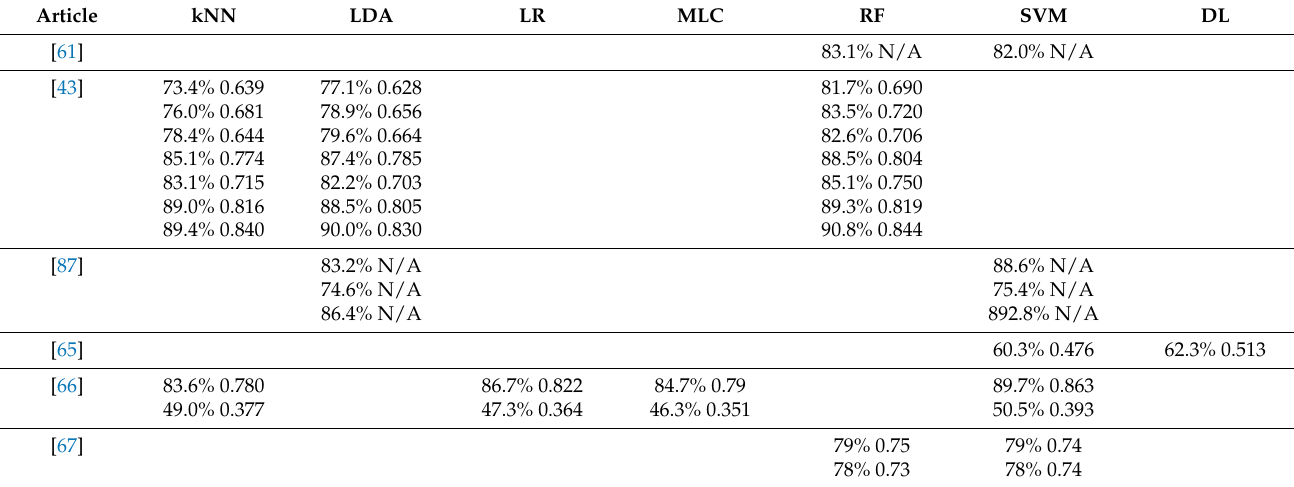
Table 5. List of reviewed studies where more than one classifier was used for tree species classification; results are presented as overall accuracy and κ coefficient (if calculated); k-NN—k-Nearest Neighbors, LDA—Linear Discriminant Analysis, LR—Logistic Regression, MLC—Maximum-Likelihood classifier, RF—Random Forest, SVM—Support Machine Vectors, DL—Deep Learning